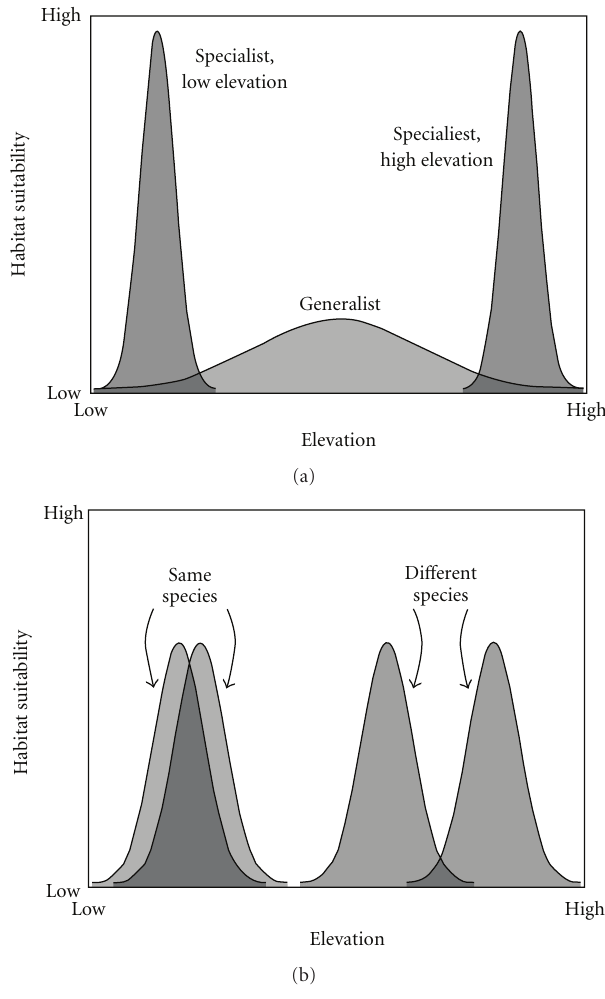
Figure 2: A schematic demonstrating plant species niche spaces, showing (a) specialists and generalists relative to elevation. Spe- cialists have small standard deviations in niche dimension and generalists have large standard deviations. Plants with niches that overlap (b) su ffi ciently in niche dimension are considered the same species and are able to breed. Plants with niches that do not overlap su ffi ciently are separate species.